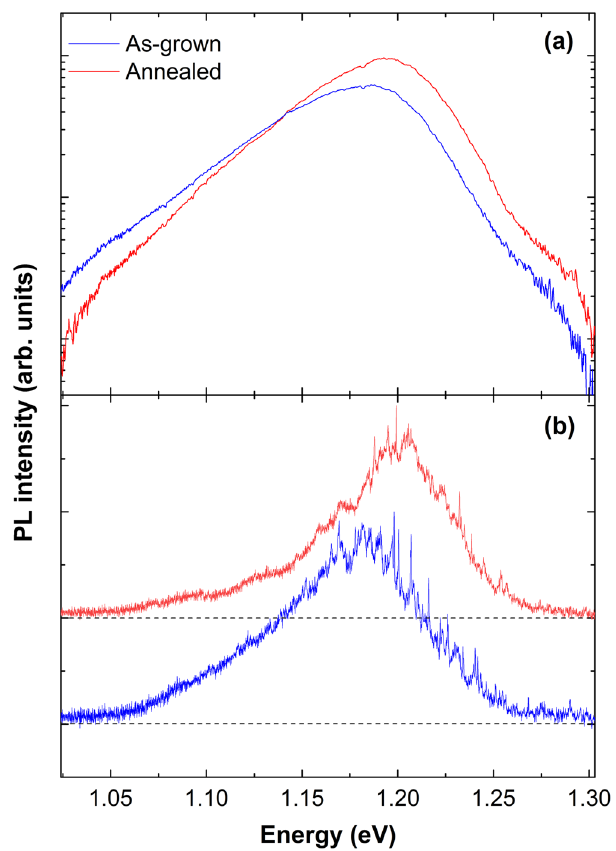
Figure 2. Low-temperature PL spectra. ( a ) PL spectra of as-grown (blue) and annealed (red) NW ensembles at 5 K plotted in semilogarithmic scale. ( b ) Representative PL spectra of single as-grown (blue) and annealed (red) NWs at 5 K. Single NW spectra are normalized to the same maximum intensity and are shifted vertically for